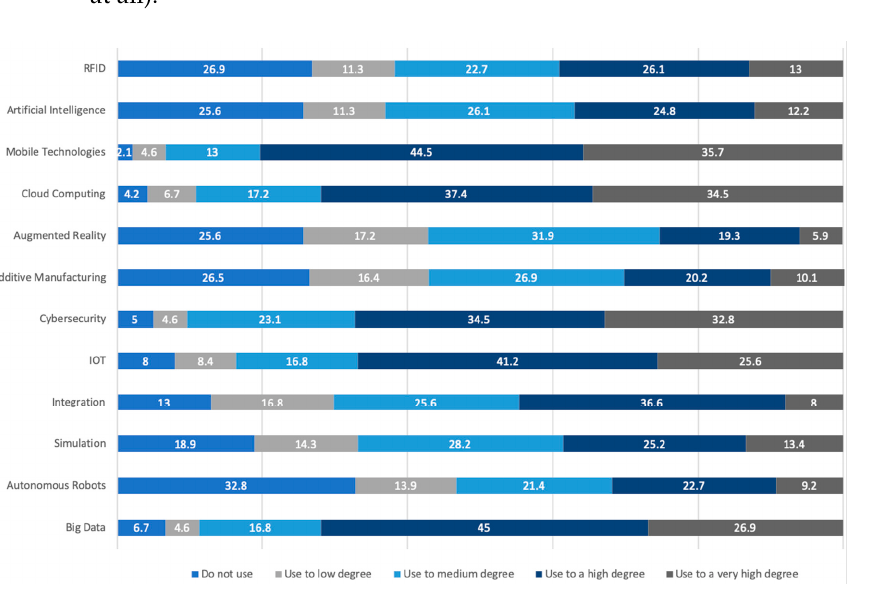
Figure 1. Industry 4.0 technologies (stacked chart).